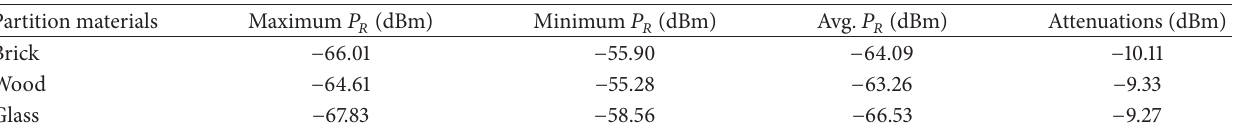
Table 5: Obtained minimum, maximum, average, and deviations of received power when a CU moves along a specific direction in the given scenario.